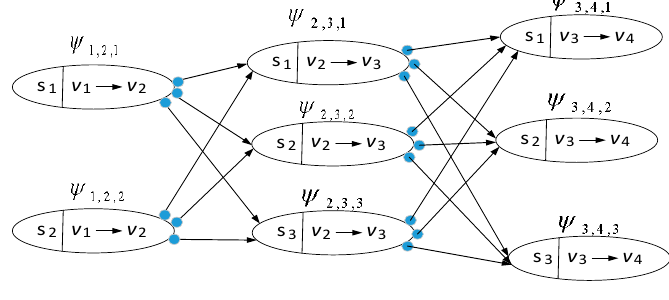
Figure 2. The proposed augmented graph.